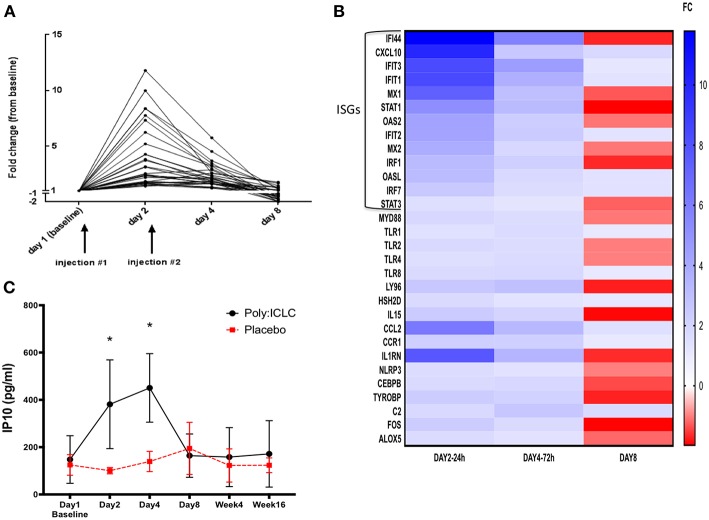
Transient upregulation of pro-inflammatory genes in subjects who received Poly-ICLC, with strong induction of interferon pathway. Transcriptional responses were evaluated longitudinally in subjects' PBMCs using NanoString Technologies (nCounter® gene expression panel, human inflammation kit). (A) Fold change (FC) from baseline of significantly upregulated genes from subjects in Arm A (Poly-ICLC) are depicted graphically over time through day 8. Transient upregulation of several genes occurred (N = 31), generally peaking at 24 h and returning to baseline shortly thereafter. No significant changes were observed in subjects' PBMCs in Arm B (Placebo) (not shown). (B) Heat map of all significantly induced genes in Arm A (Poly-ICLC) represented as a FC over baseline. Most of the highly upregulated genes were found to be interferon-stimulated genes (ISGs) FDR < 1, FC ≥ ±1.5. (C) In concordance with strong upregulation of ISGs, plasma levels of IP-10 were transiently upregulated in subjects in Arm A Poly-ICLC (N = 12) vs. those in Arm B Placebo (N = 3). *p < 0.001.